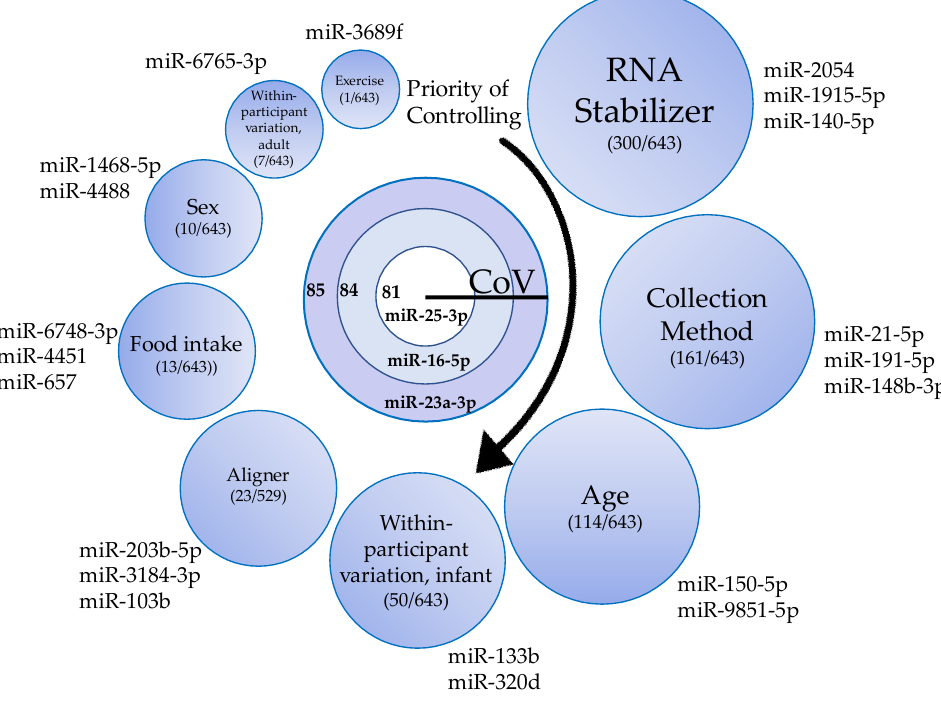
Figure 8. Top “control miRNA” candidates and ranked confounders for consideration. The top three control miRNA candidates identified by coefficient of variation (CoV) and abundance (center). Technical and biologic variables that may impact miRNA analyses are rank-ordered based upon the number of miRNAs differentially expressed between conditions (except age and BMI, where rank is based on the number of miRNAs with an |R| ≥ 0.5). Zero miRNA correlated with BMI with an |R| greater than or equal to 0.5. All miRNAs listed outside of the variable circles are the top significantly different miRNA between conditions.